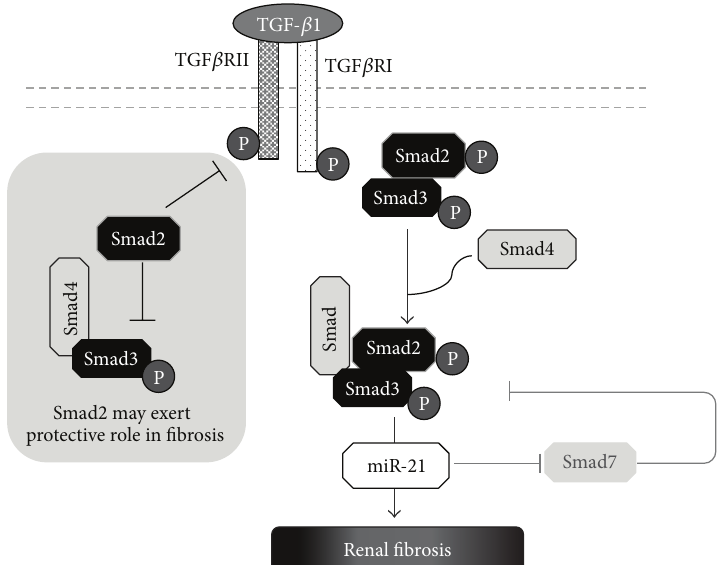
Figure 3: The role of Smad proteins in renal fibrosis. After binding to its receptor, TGF 𝛽 1 stimulates Smad-mediated renal fibrosis. The phosphorylatedSmad2andSmad3bindtoSmad4andformtheSmadcomplexleadingtotheupregulationofmiR-21andfibrosisdevelopment. Of note, miR-21 inhibits Smad7, which under normal conditions acts as a negative regulator of TGF- 𝛽 1/Smad3 signaling. Smad2 may protect against renal fibrosis through inhibition of Smad3 binding to TGF 𝛽 RI as well as by blocking Smad3 nuclear translocation.